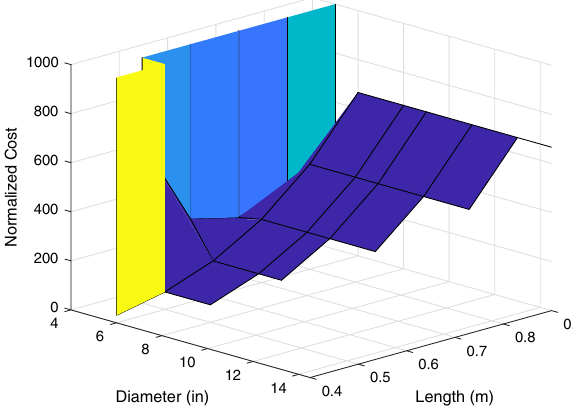
Figure 3. For (cid:31) = 1 , the cost surface shows the cost as a function of the mean error across the scenarios. Low cost on this surface corresponds to good performance over the varying wind profiles 32 .